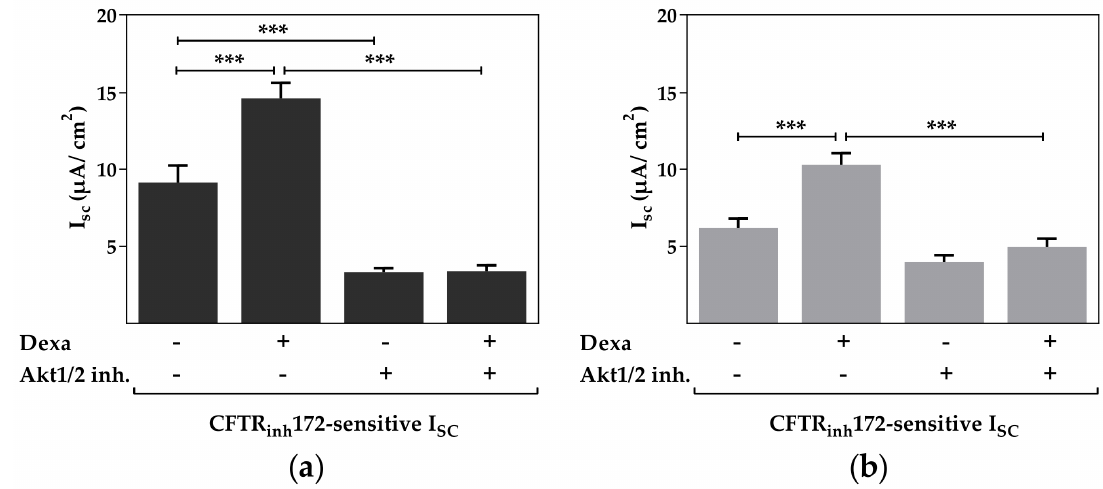
Figure 4. Akt1/2 kinase inhibitor prevents the increase of CFTR activity induced by dexa. Cells were treated with 100 nM dexa and Akt1/2 kinase inhibitor (10 µM) for 24 h. Data bars represent the mean + SEM of I SC . ( a ) In primary airway epithelial cells, the CFTR inh 172-sensitive I SC was increased by dexa. Addition of Akt1/2 kinase inhibitor prevented the dexa-induced increase of CFTR activity ( n = 11–14; *** p < 0.001, ANOVA with Tukey’s post hoc test); ( b ) in Calu-3 cells the CFTR inh 172-sensitive I SC was increased by dexa. Likewise, addition of Akt1/2 kinase inhibitor prevented the dexa-induced increase of CFTR activity ( n = 36–37, *** p < 0.001, ANOVA with Tukey’s post hoc test).